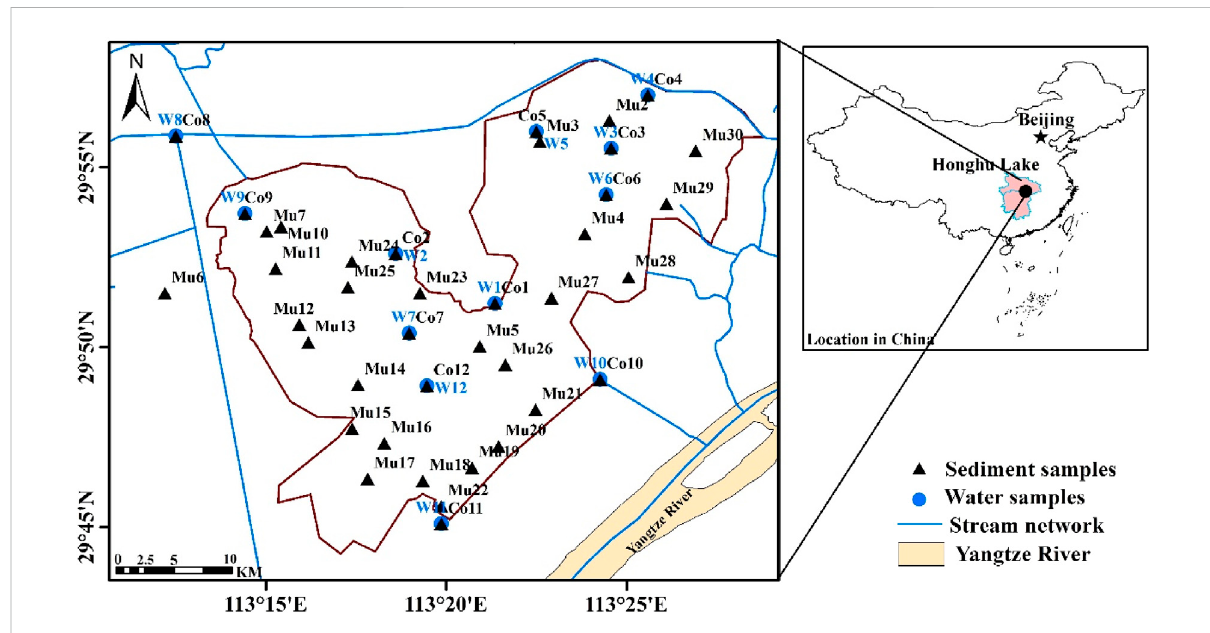
FIGURE 1 Locations of Water and Sediment Samples from the Honghu